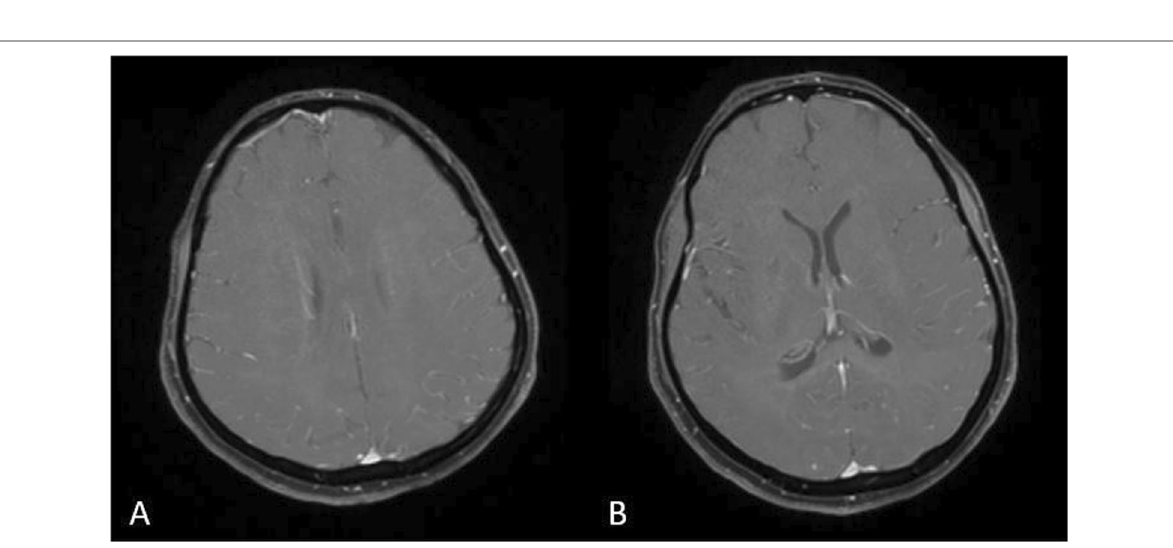
Fig. 3 A and B Showing T1 post-contrast images with no contrast enhancement of the diffusion restricting